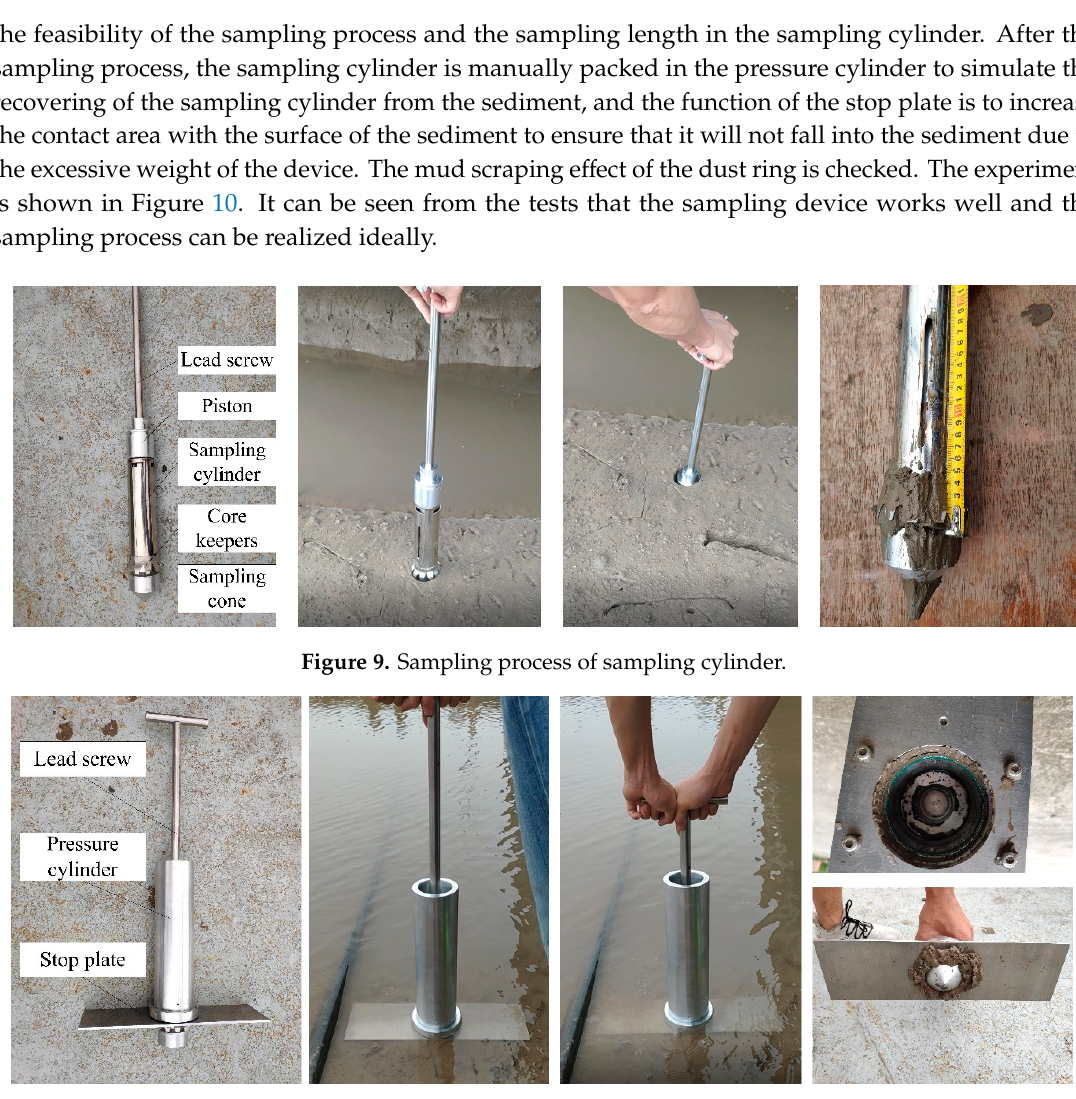
Figure 10. Sampling process with pressure cylinder and dust ring.